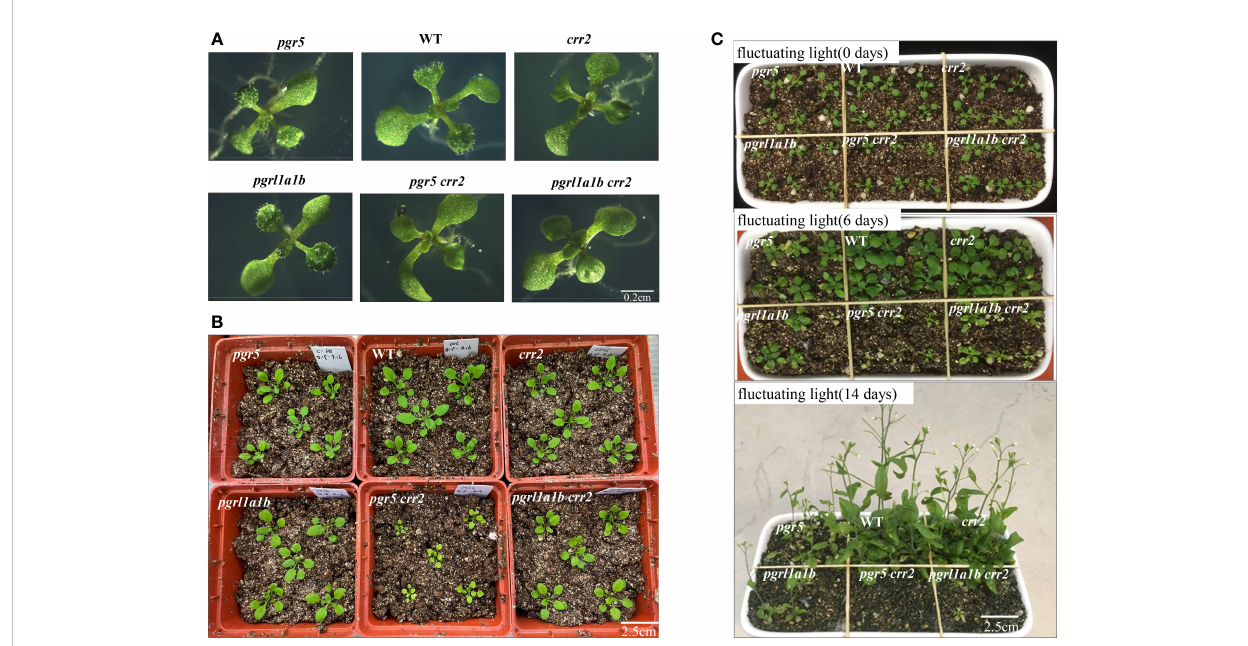
FIGURE 1 Growth phenotypes of CET mutant lines under different light conditions. (A) Plants were grown on agar plates containing Murashige and Skoog (MS) medium, 2% sucrose, and 0.8% agar at a light intensity of 60 m mol m − 2 s − 1 at 22°C for 10 days. Bars = 0.2 cm. (B) After plants were cultured on the agar plates for 10 days, they were transferred to soil for 2 weeks at a light intensity of 120 m mol m − 2 s − 1 at 22°C. Bars = 2.5 cm. (C) After the plants grew on the agar plate for 7 days, they were transferred to soil for 5 days under constant light of 80 m mol m − 2 s − 1 and shifted to fl uctuating light with high light (600 m mol m − 2 s − 1 ) for a 1-min cycle and low light (60 m mol m − 2 s − 1 ) for a 5-min cycle at 22°C. Fluctuating light (0 days): the growth phenotype before the fl uctuating light treatment. Fluctuating light (6 days): the growth phenotype in fl uctuating light with 6 days. Fluctuating light (14 days): the growth phenotype in fl uctuating light with 14 days. Bars = 2.5